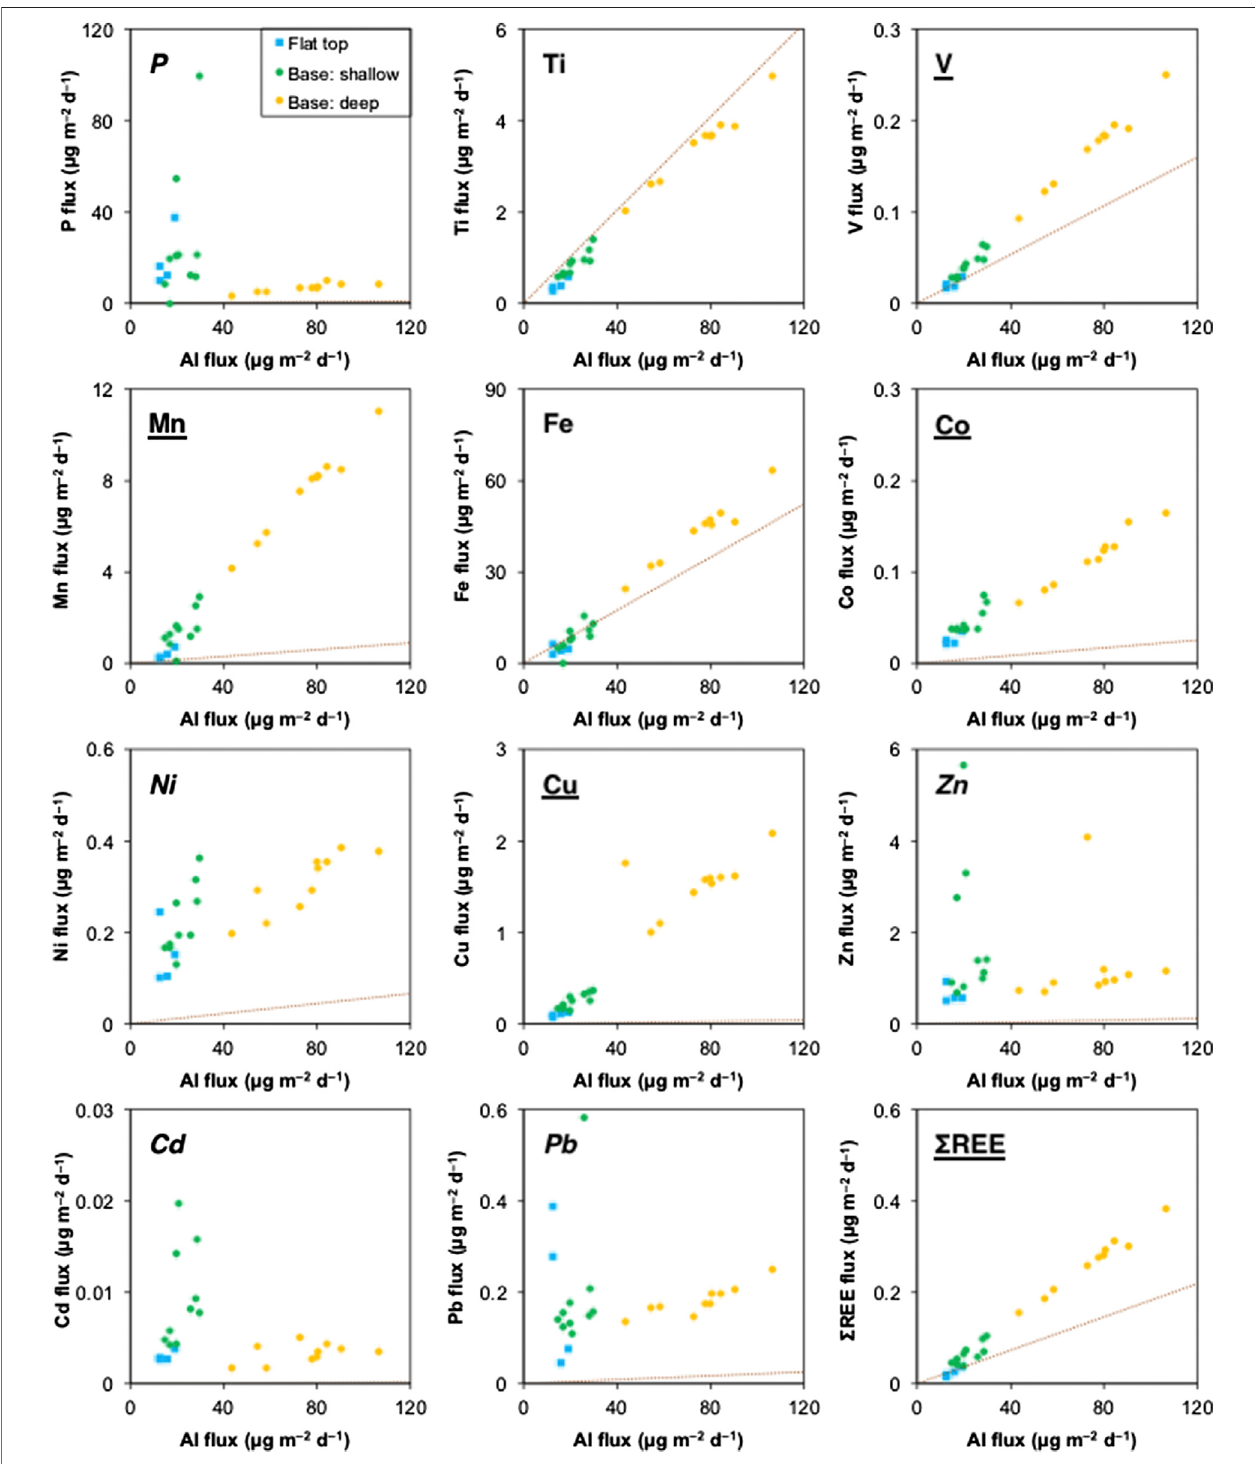
FIGURE 7 | Correlations between trace element and Al fl uxes in sediment trap samples from JA06 Seamount. Dashed lines indicate average ratios in upper continental crust (McLennan, 2001). Element names in individual fi gures with bold, italic, and underline indicate the belonging to lithogenic, biogenic, and scavenging groups,